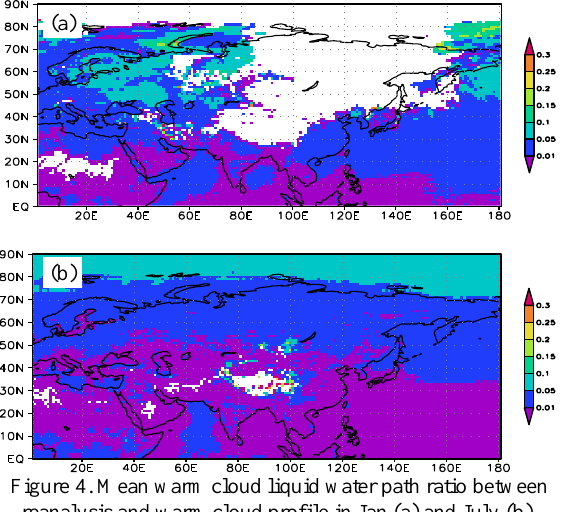
Figure 4. Mean warm cloud liquid water path ratio between reanalysis and warm cloud profile in Jan (a) and July